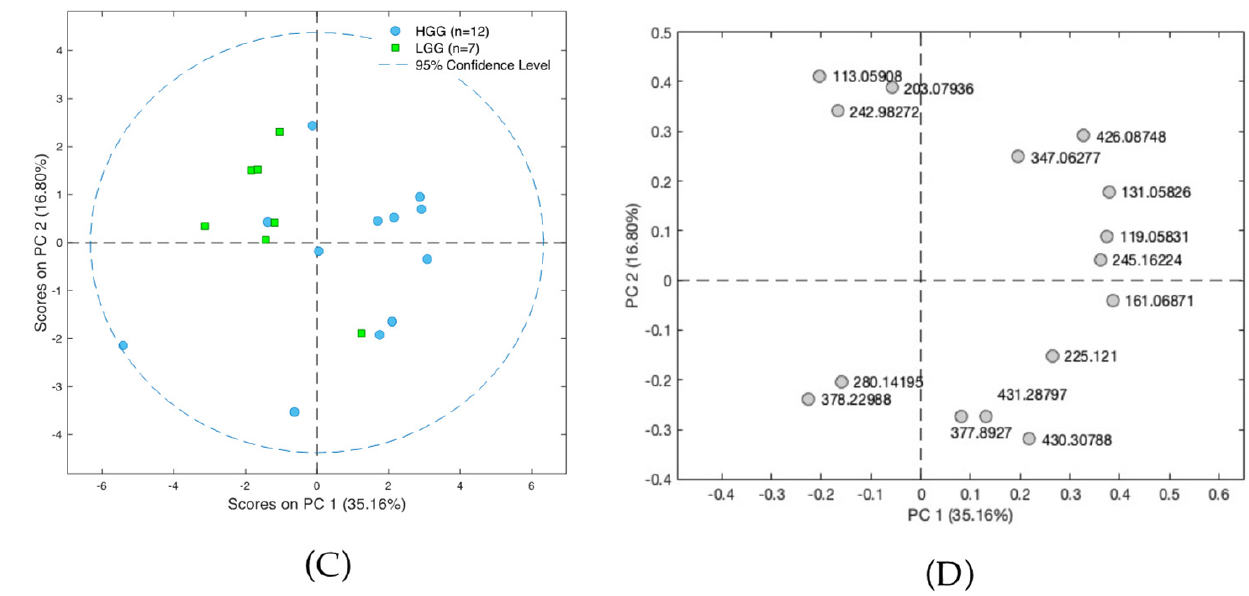
Figure 4. ( A ) Scores plot of the PLS-DA model showing differences between groups of high-grade- malignancy gliomas (HGG) and low-grade-malignancy gliomas (LGG). Results presented on three first latent variables. ( B ) Scores plot of the OPLS-DA two-class model of LC-MS data. The labels correspond to patients with high-grade-malignancy gliomas (blue circles) and those with low-grade- malignancy gliomas (green squares). ( C ) PCA scores plot showing data for patients with high-grade- malignancy gliomas (blue squares) and those low-grade-malignancy gliomas (green circles). ( D ) PCA loadings plot for HGG and LGG patients.